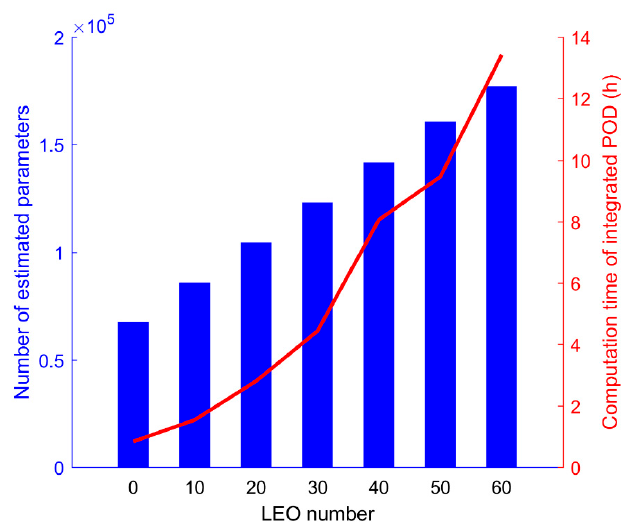
Figure 13. Number of estimated parameters and computation time of the integrated POD with LEO satellites in nearly-polar orbit.